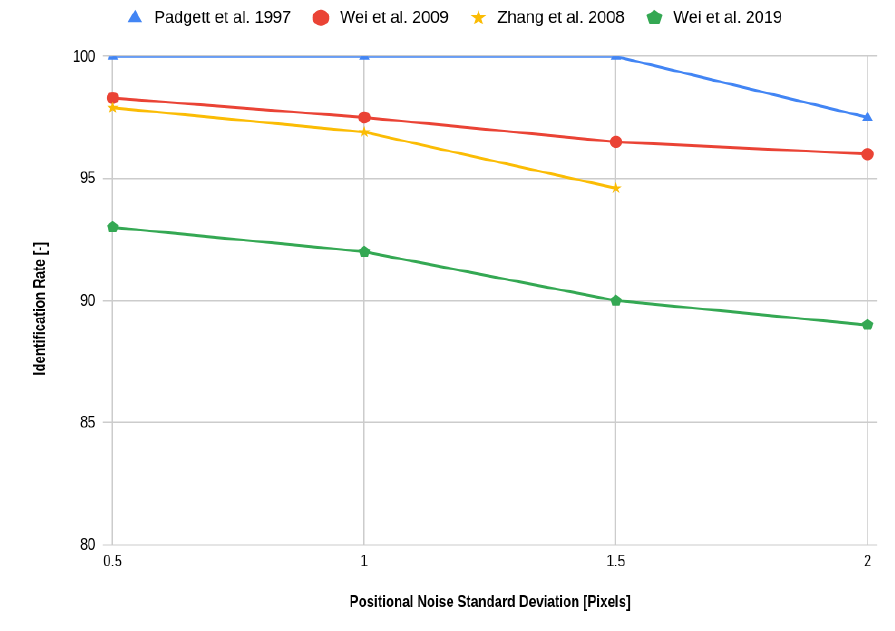
Figure 11. Reported performance of the grid algorithm